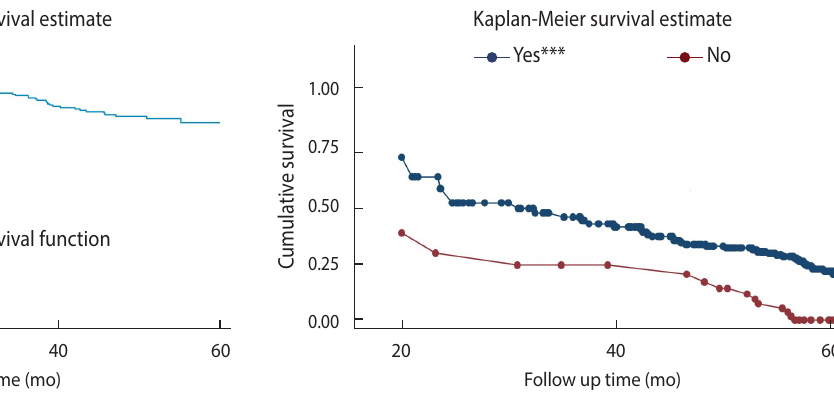
Figure 1. Overall Kaplan-Meier survival curve with 95% confidence intervals (CIs) for tuberculosis-free survival among children receiv- ing chronic human immunodeficiency virus care at Adama Referral Hospital and Medical College.